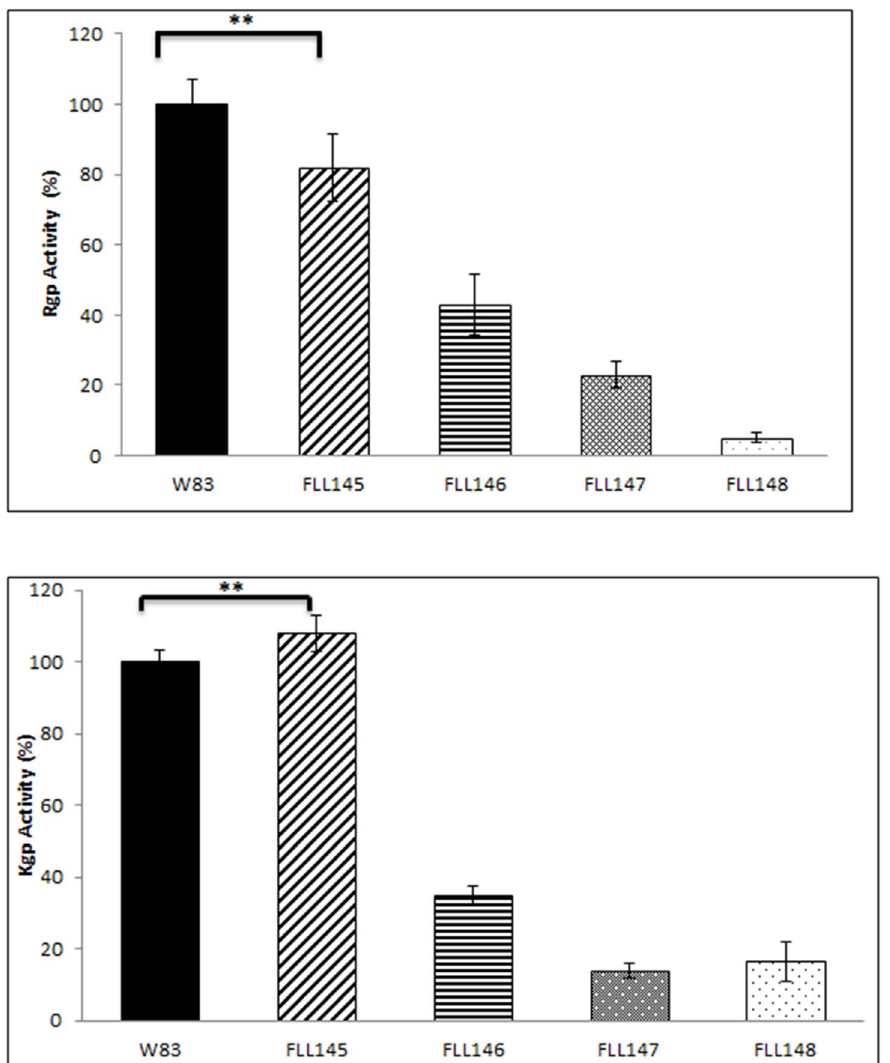
Figure 3. Proteolytic activity of P.gingivalis mutants. P. gingivalis strains were grown to late log phase OD 600 of 1.2 in 50 ml of BHI broth supplemented with hemin and vitamin K. Panel A ; whole cell culture was analyzed for Rgp (BAPNA) activity (**P # 0.01). Panel B ; whole cell culture was analyzed for Kgp (ALNA) activity. The results shown are representative of 3 independent experiments performed in triplicate (*P # 0.01).